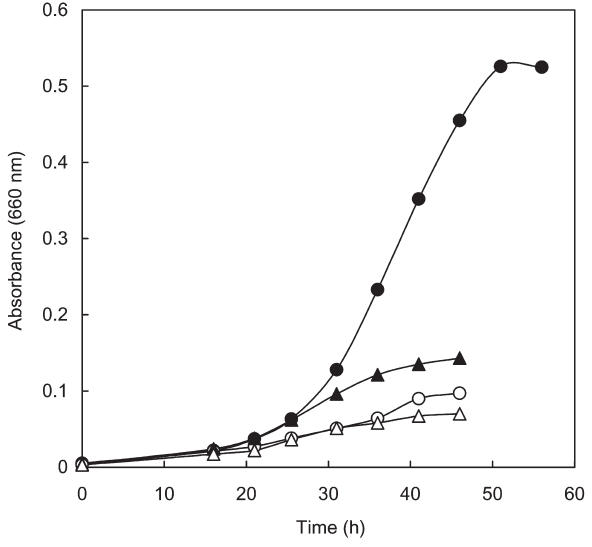
Figure 2. Growth curves of strain VA1 in atmospheric air. Strain VA1 was cultivated at 90 °C in TY medium without shaking ( (cid:2) ) and with shaking ( (cid:3) ), and in TY medium supplemented with 0.3% thiosulfate without shaking ( (cid:4) ) and with shaking ( (cid:5) ).